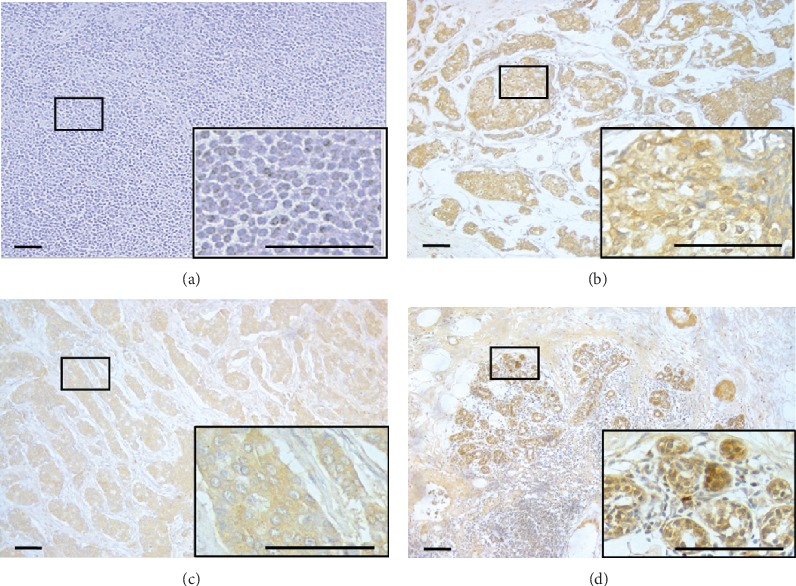
Representative staining of SGLT1 in different subtypes of breast cancer (×100, ×400). (a) Negative immunoreactions. Scale bar: 100 μm. (b) Positive staining of SGLT1 in luminal-like breast cancer. (c) Positive staining of SGLT1 in HER2+ breast cancer. (d) Positive staining of SGLT1 in basal-like breast cancer.